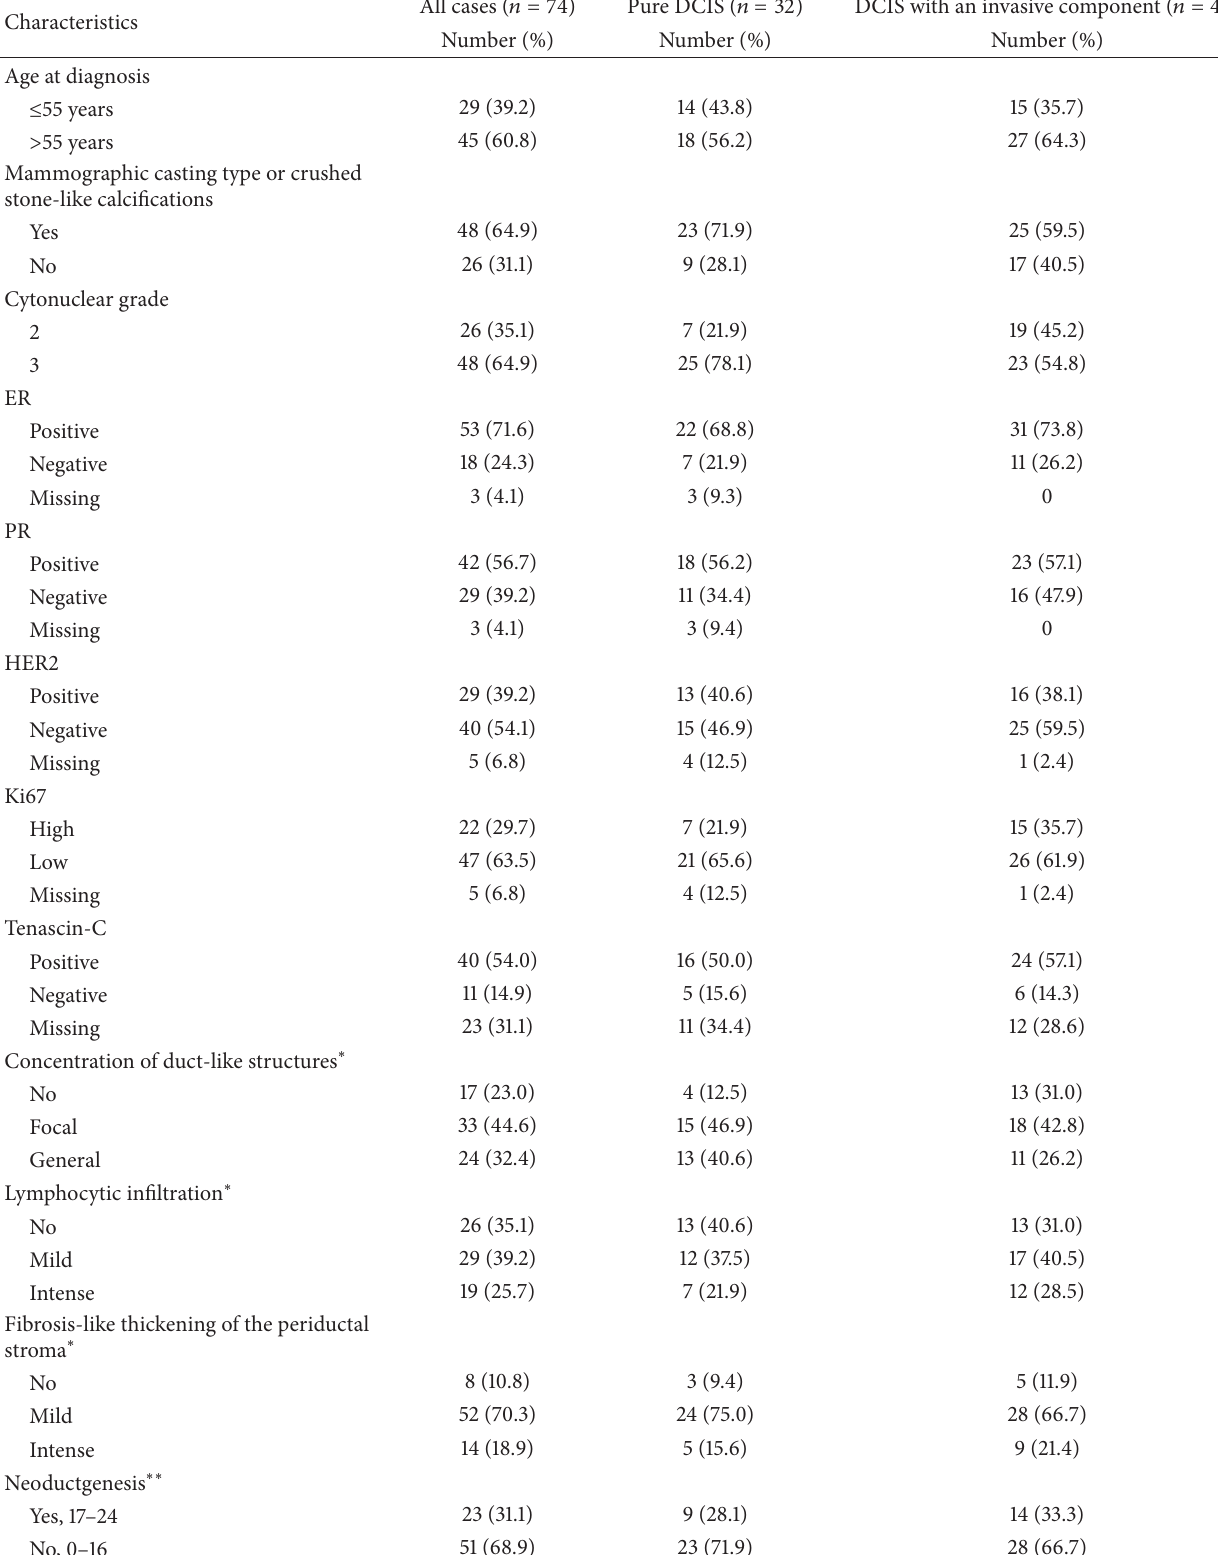
Table 2: Baseline characteristics in 74 women with DCIS with or without an invasive